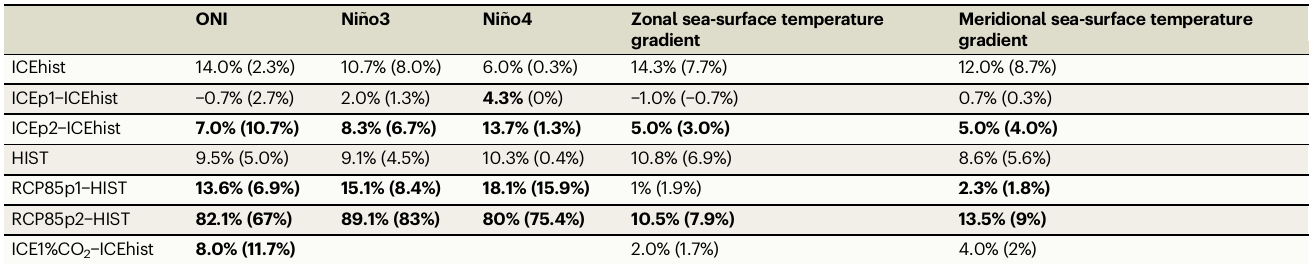
Table 1 | Frequency of strong El Nin ̃ o events in the time-slice-coupled model experiment with fi xed Arctic sea ice during 1980 – 1999 (ICEhist, row 2) and the historical simulation during 1980 – 1999 from the Community Earth System Model (CESM) large ensemble (HIST, row 5) ONI Nin ̃ o3 Nin ̃